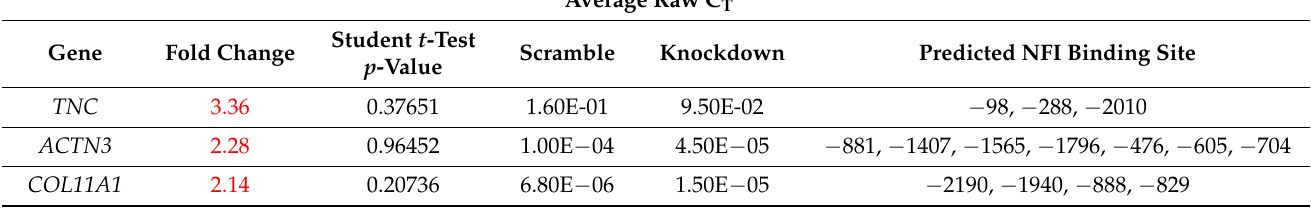
the expression of other adherens junction genes and ECM genes via qPCR (Table 4 and Table S1). We observed downregulation of genes associated with adherens junction proteins in NFIX KD cells compared to controls including ACTN4 , CSNK2A2 , CTNNA3 , CTNND1 , DSG1 and DSG3 (Table 4). These genes encode for a range of adherens junction organising proteins, catenins, and desmosomal cadherins and their downregulation in NFIX KD cells may indicate abnormal adherens junction structure compared to controls which may impair epithelial cell-cell adhesion. In contrast, some adherens junction associated genes were upregulated in NFIX KD cells compared to controls including ACTN3 , CDSN , DSP , NME1 , PKP2 , TJP1 and WASF1 (Table 4). We also found that ECM associated genes were downregulated in NFIX KD cells compared to controls including CD44 , COL6A1 , COL14A1 , ICAM1 , ITGA3 , ITGA4 , ITGB1 , LAMA2 , LAMB3 , LAMC1 , MMP12 , MMP14 , SELL , SPP1 , THBS2 and TIMP3 (Table S2). These genes encode for proteins associated with a broad range of functions including ECM component proteins, ECM binding proteins and ECM remodelling proteins. In contrast COL11A1 , and TNC were both found to be upregulated in NFIX KD cells compared to controls (Table S2). Table 4. Differential gene expression observed in NFIX knockdown lentivirus treated MCF7 cells as compared to scramble lentivirus treated cells as compared via a “human adherens junctions” and a “human extracellular matrix and adhesion molecules RT 2 qPCR profiler array. Genes with a Fold change > 2 (red) or < 0.5 (blue) were considered to have significantly upregulated or downregulated expression respectively. Similarly, genes which were found to have a p -value < 0.05 via two-tailed students t -test were also considered to be significantly upregulated or downregulated respectively. Significant values were calculated using a cycle threshold of 0.095, similarly samples were checked for genomic contamination and mRNA integrity using in array controls. Samples were found to have good quality mRNA (CTPPC = 20 ± 2) and had a low chance of genomic contamination (CTHGDC ≥ 33). An n = 3 NFIX shRNA lentivirus MCF7 cells and a scramble RNA lentivirus MCF7